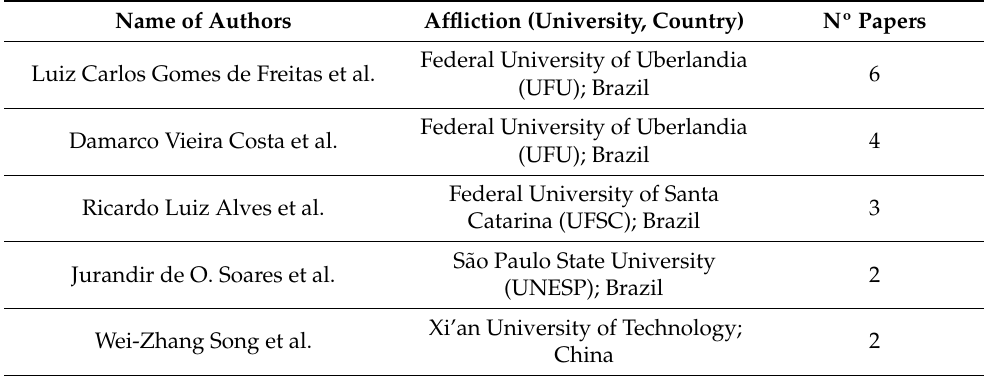
Table 4. Authors on HTR and the number of papers